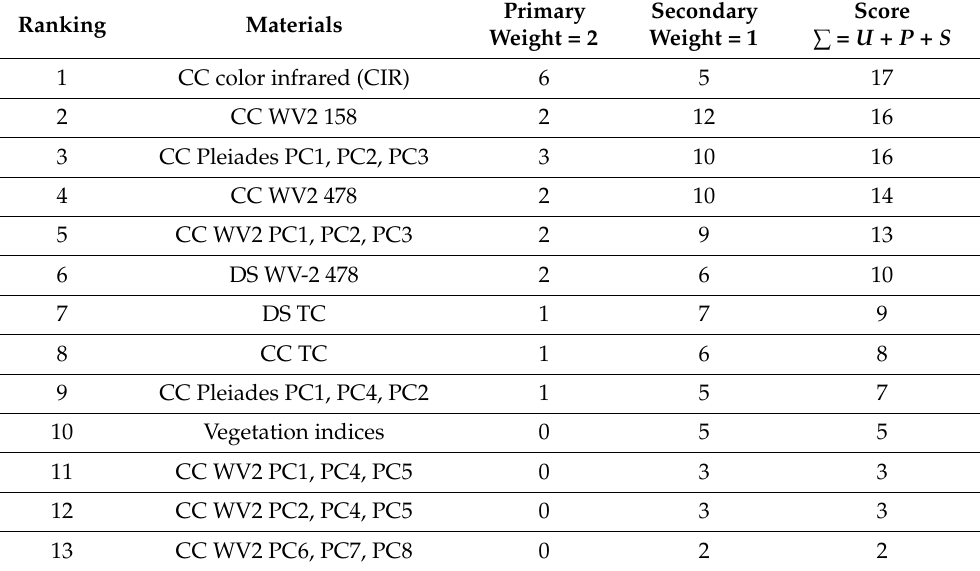
Table 9. Ranking of the usefulness of the multispectral data processing methods used by the